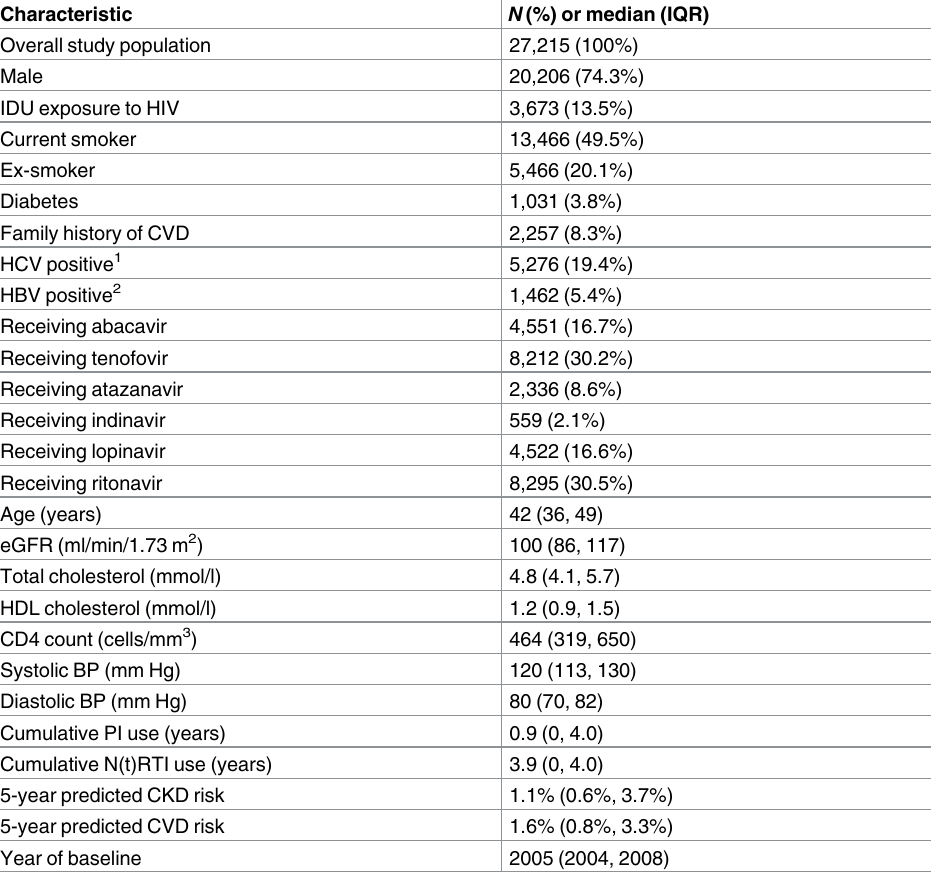
Table 1. Participant baseline characteristics.